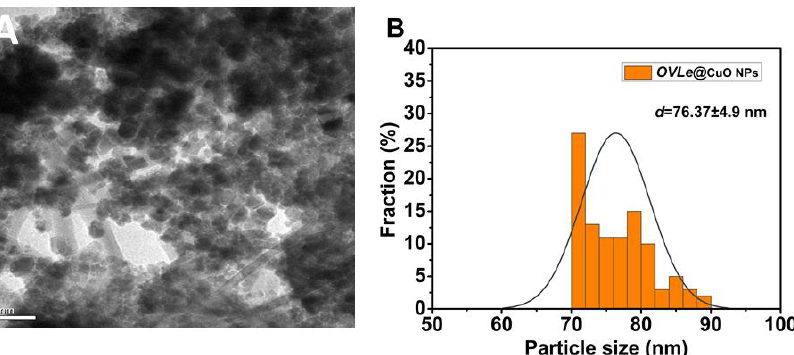
Figure 5. ( A ) Average particle size of prepared CuO @OVLe NCs evaluated utilising TEM (scale bar = 50 nm). ( B ) The size distribution of prepared CuO @OVLe NCs data is shown as the mean ± SD ( n =